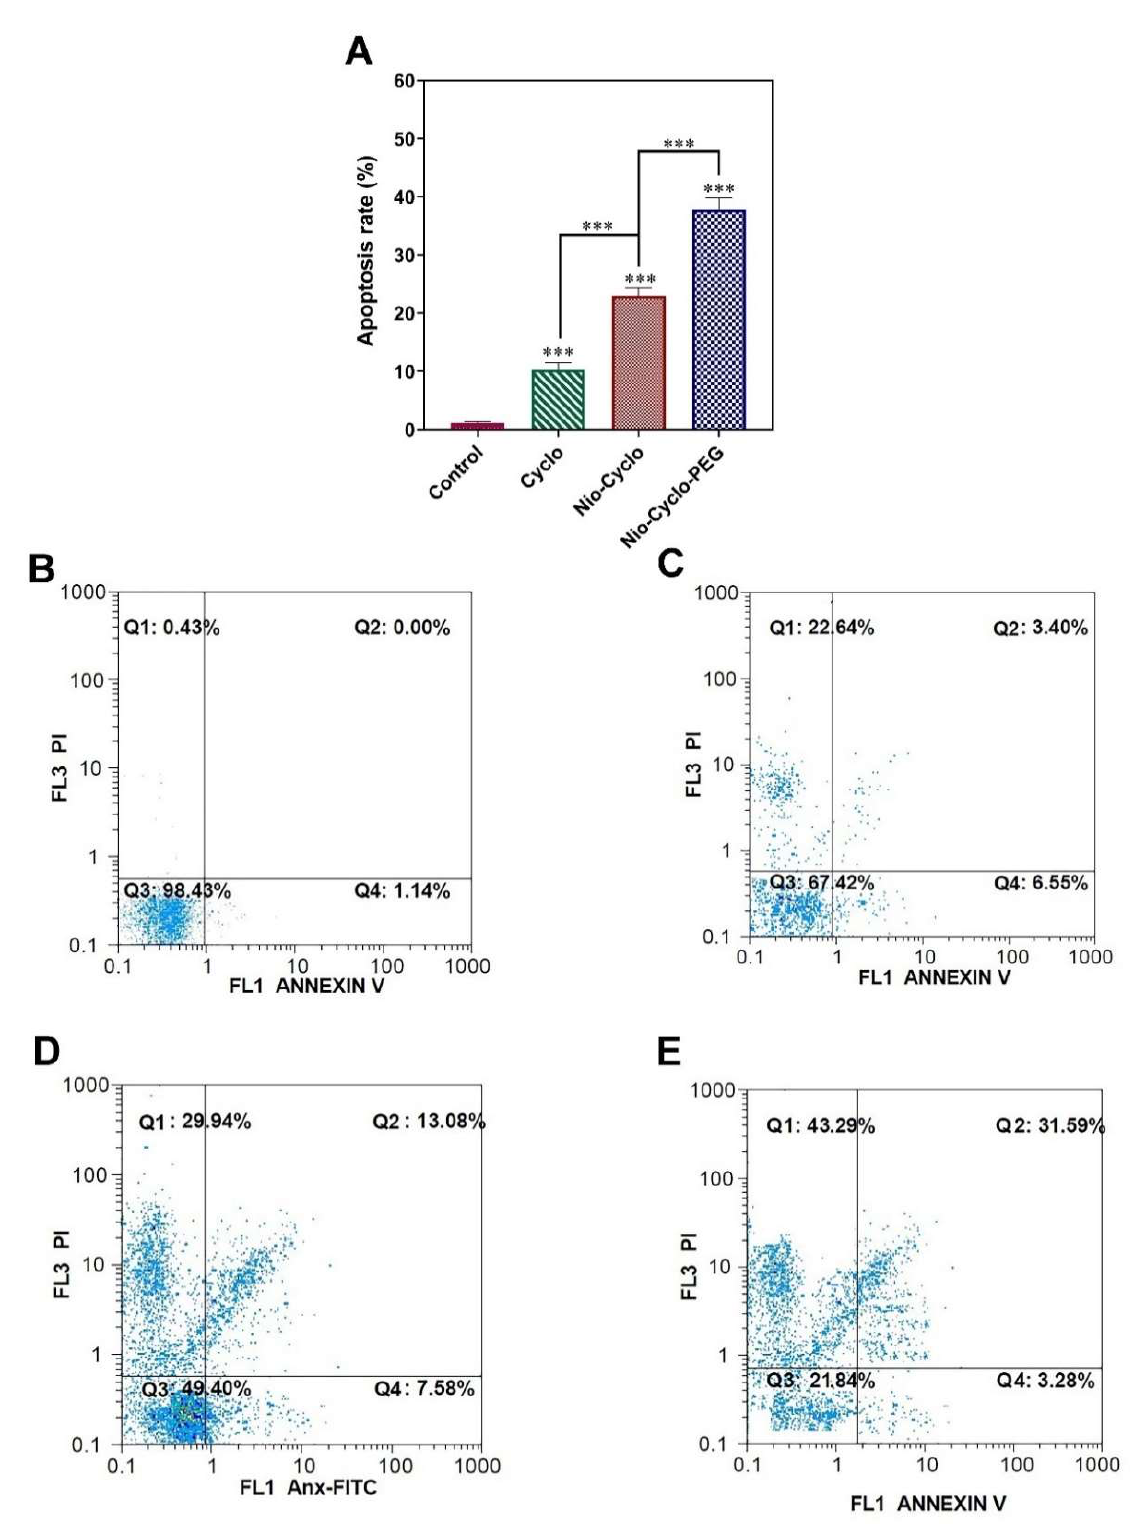
Figure 6. (A ) The quantitative apoptosis rate analysis of AGS cancer cells after the treatment with different drug samples. The flow cytometry of AGS cells after treatment with ( B ) control (no drug), ( C ) Cyclo (free drug), ( D ) Nio-Cyclo and ( E ) Nio-Cyclo-PEG, where Q1: percentage of necrotic cells; Q2: percentage of late apoptotic cells, Q3: percentage of live cells and Q4: percentage of early apoptotic cells. All data are represented as Mean ± SD from three independent experiments ***: p < 0.001).